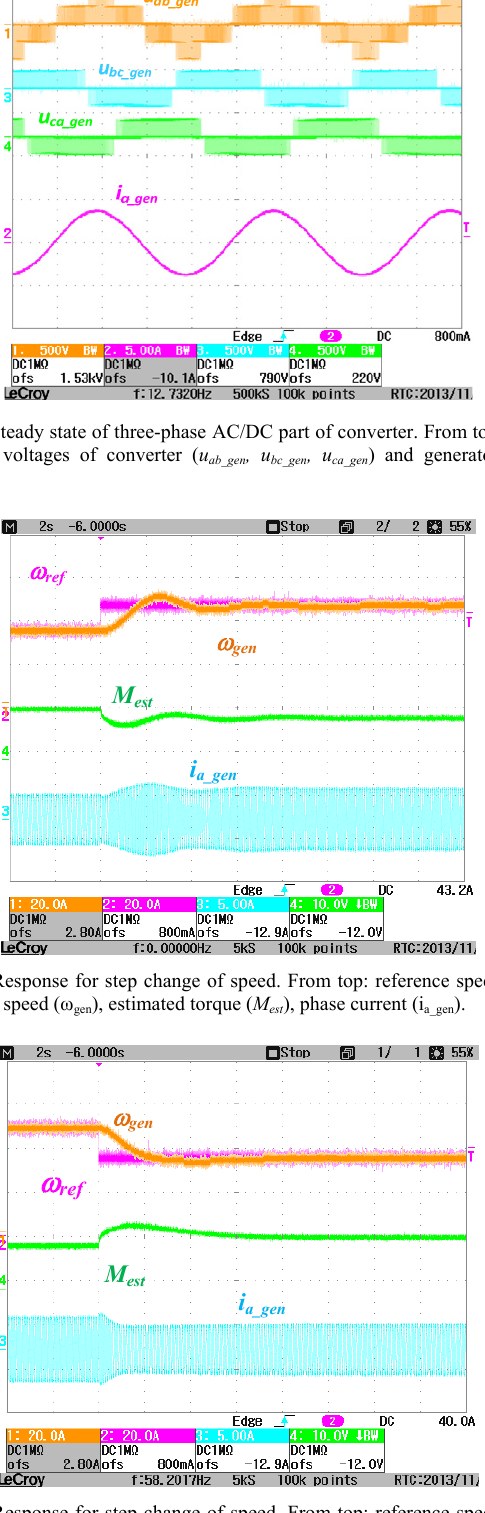
Fig. 13. Response for step change of speed. From top: reference speed ( ω ref ), measured speed ( ω gen ), estimated torque ( M est ), phase current ( i a_gen